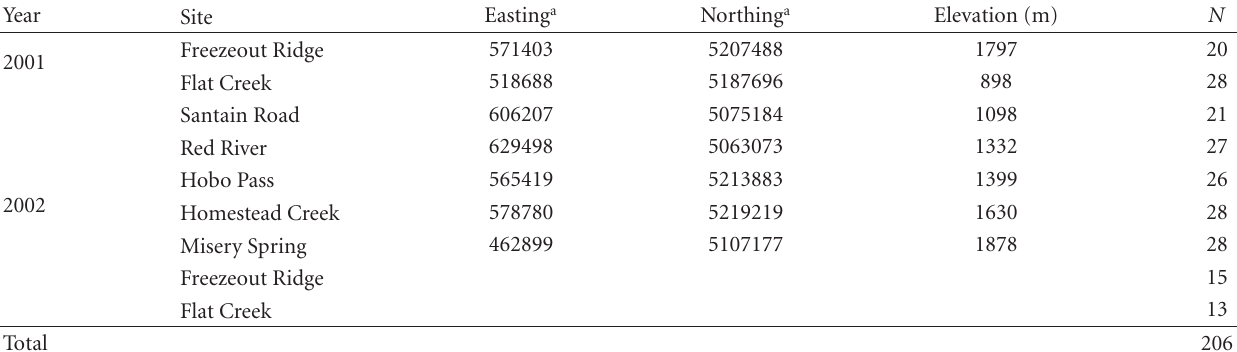
Table 1: Sampling locations, years, and number of trees per location in northern Idaho and eastern Washington from which spectral data of mature subalpine fir trees were collected.